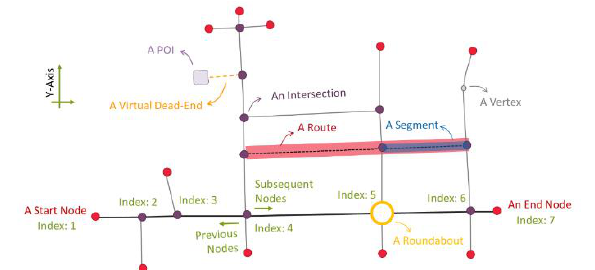
Figure 1. Data in a sketch maps in the form of a form a labeled directional